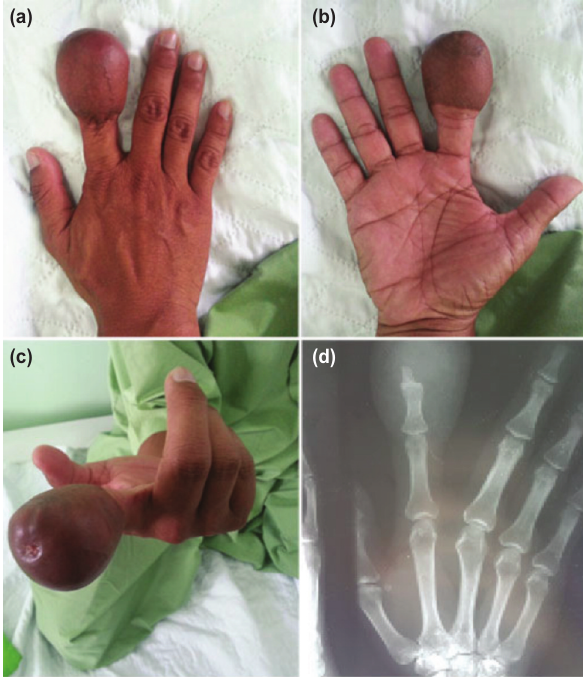
Intraoperative findings of dense fibrous tissue Fig. 2: surrounding the osteomyelitic